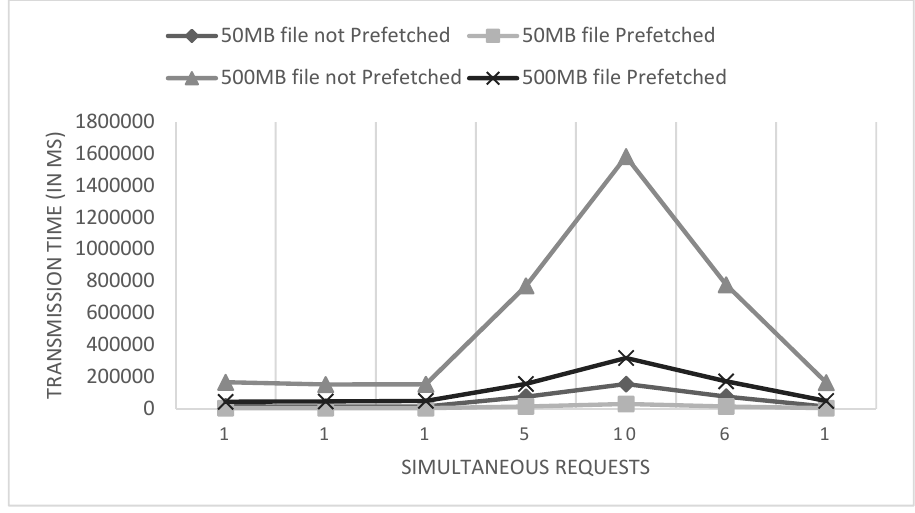
Figure 12. Average download times (in ms) of different encrypted health records while performing simultaneous requests to the deployed storage cloud and deployed in different data centers.